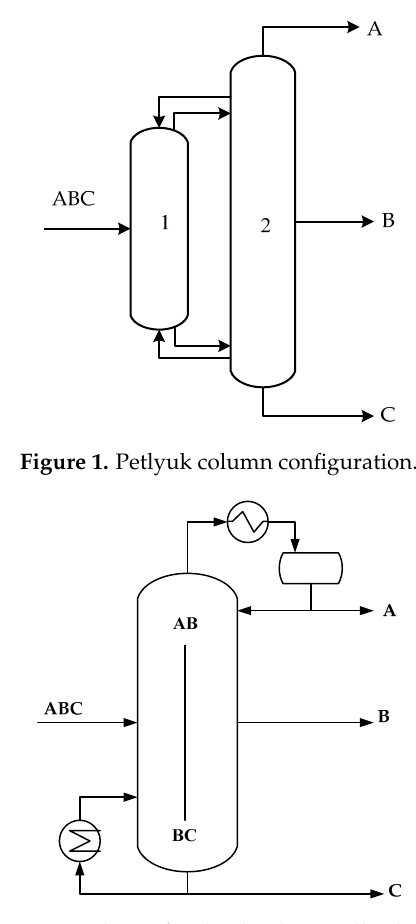
Figure 2. Scheme for the dividing wall column.